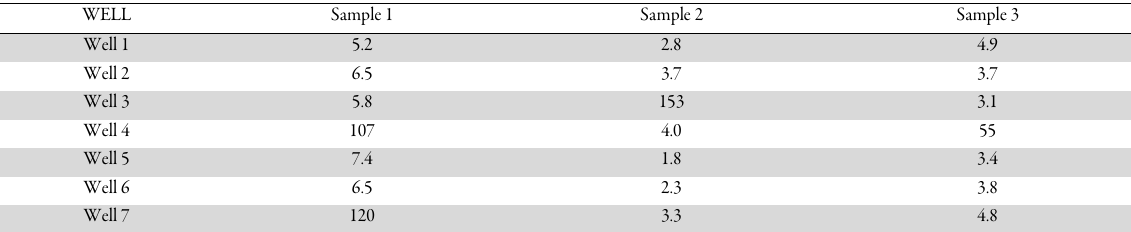
Table 3. Total coliform counts for water samples (n x 10 4 cfu/ml)